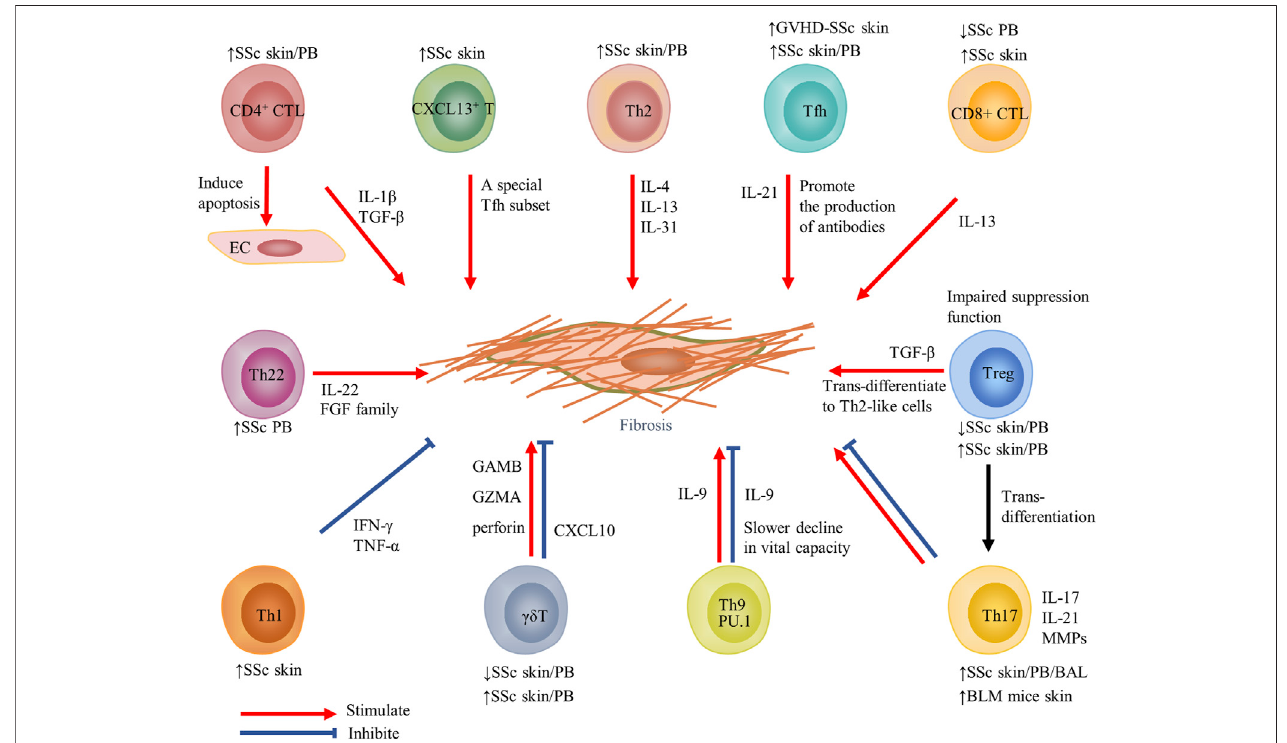
FIGURE 2 | Contribution of T-cell subsets and their cytokines to fi brosis in SSc. Changes in T-cell subsets of PB or target organs in SSc and fi brosis models are displayed above or below the cell. Red arrows indicate stimulation; blue blunted-ends indicate inhibition. SSc, systemic sclerosis; PB, peripheral blood; EC, endothelial cells; IL, interleukin; Tfh, T follicular helper; GVHD, graft-versus-host disease; and MMP, matrix